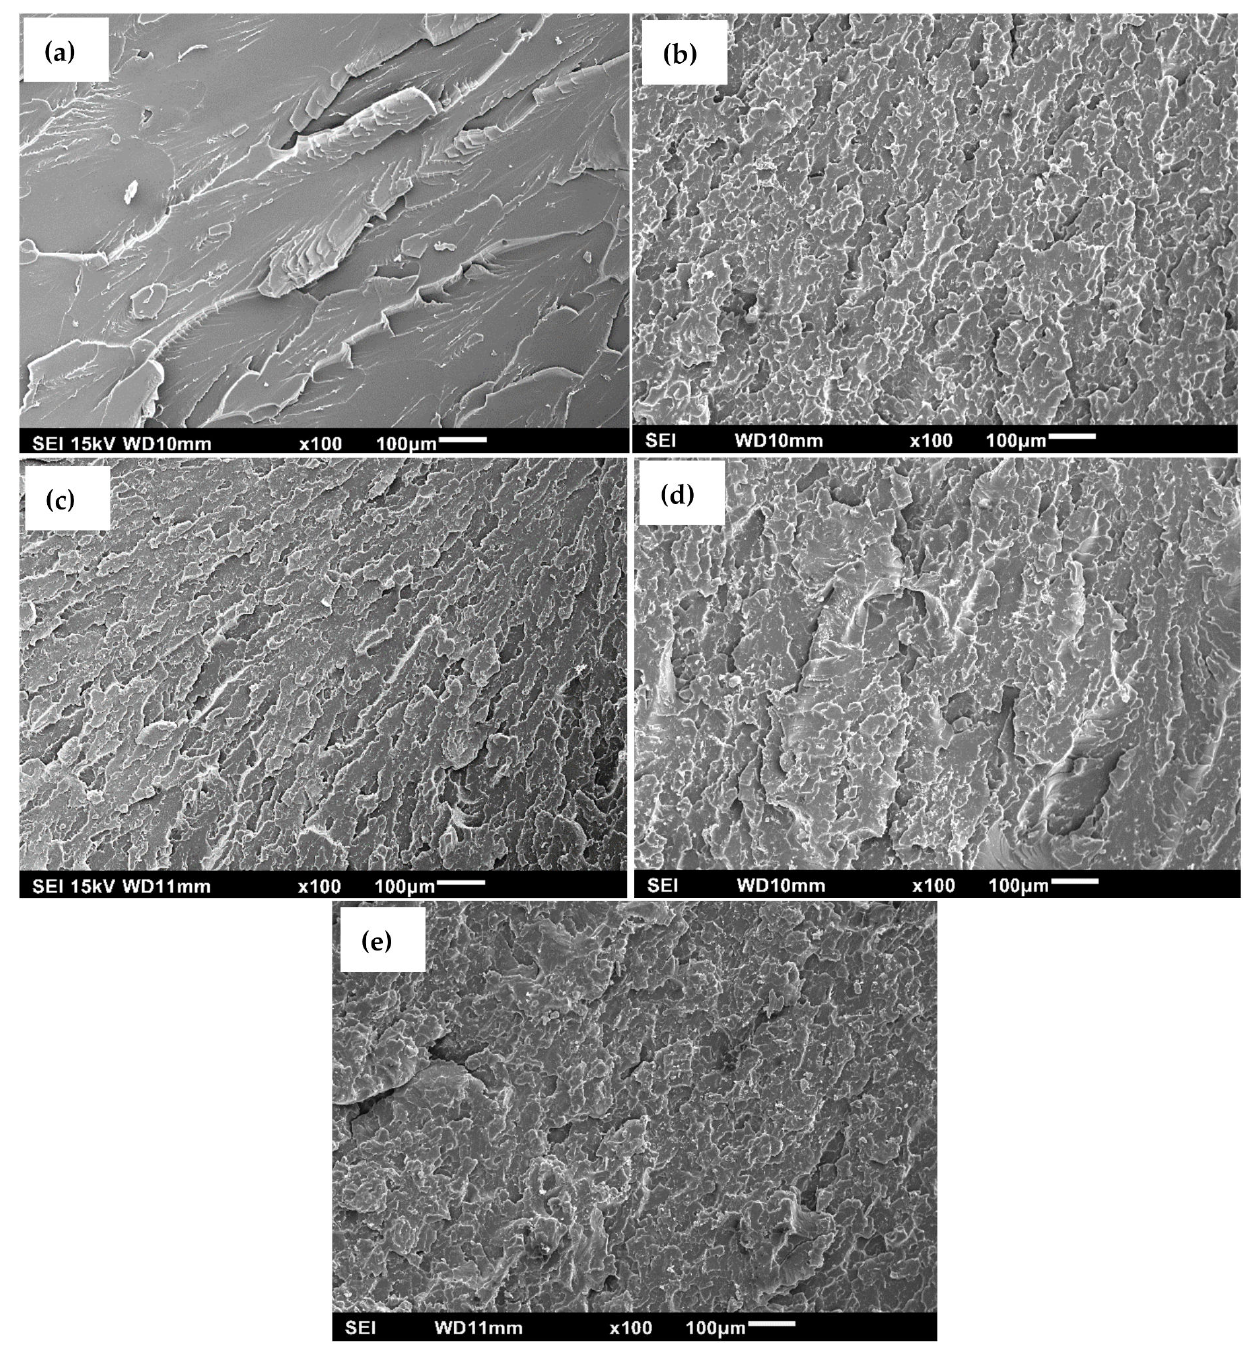
Figure 7. SEM images of fractured flexural surfaces of ( a ) pure bio-epoxy; ( b ) bio-epoxy/0.1 wt.% GO; ( c ) bio-epoxy/0.2 wt.% GO; ( d ) bio-epoxy/0.3 wt.% GO and ( e ) bio-epoxy/0.6 wt.% GO